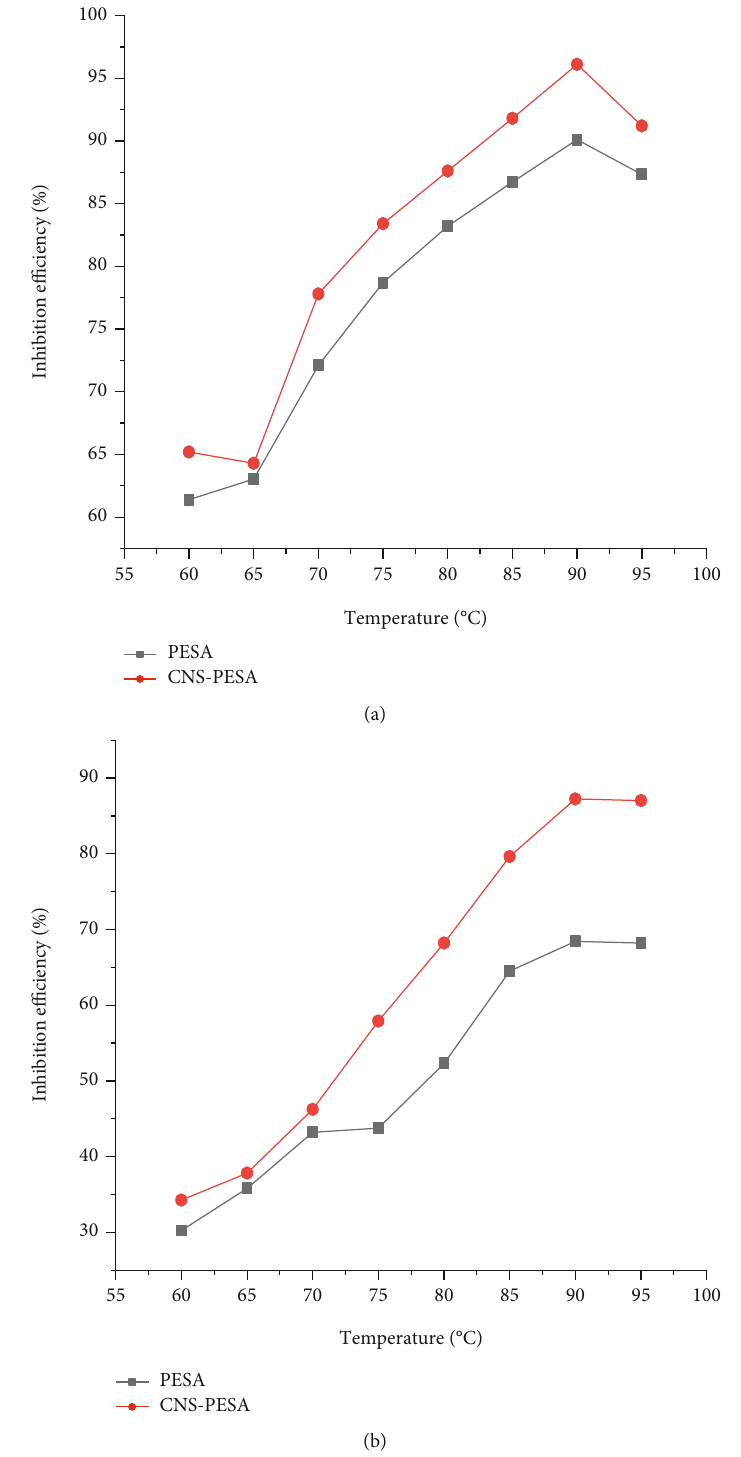
Figure 8: E ff ect of scale inhibition performance of PESA and CNS-PESA for (a) calcium carbonate and (b) calcium phosphate scale at di ff erent reaction